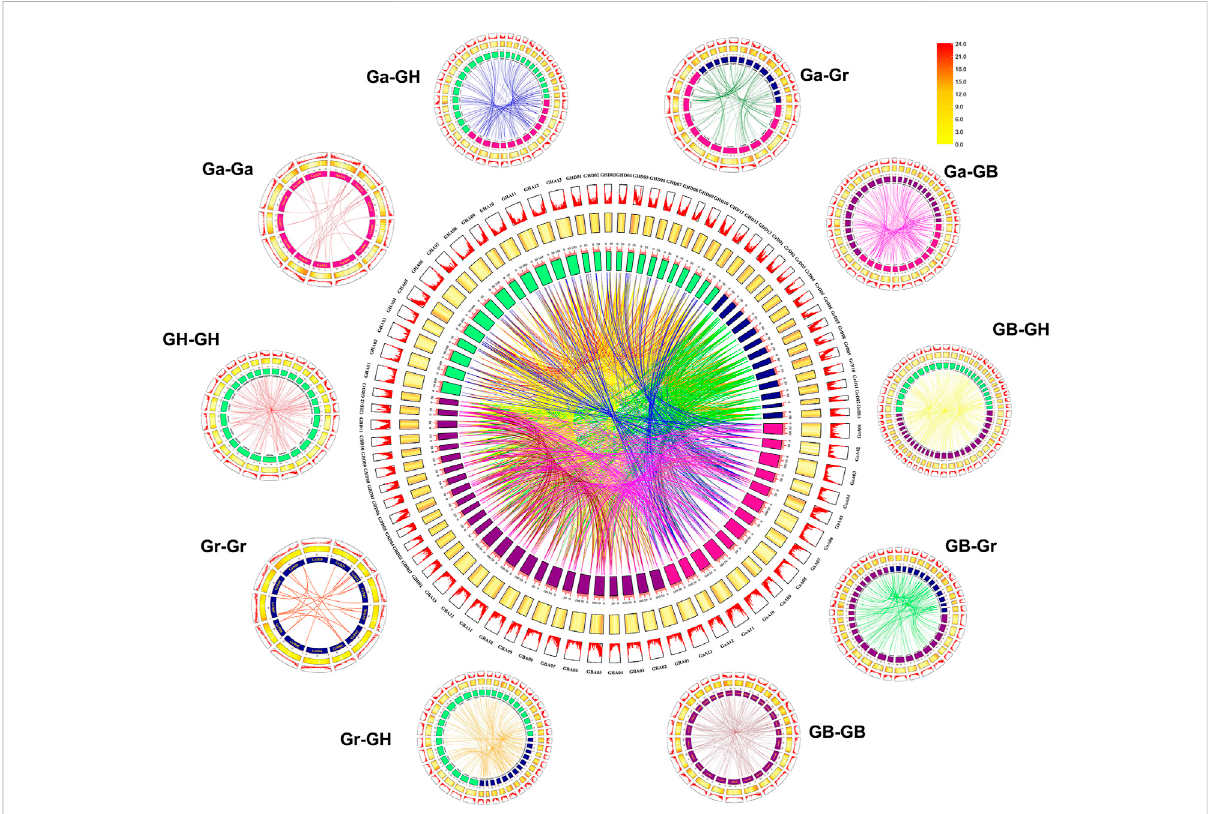
FIGURE 6 Syntenic relationship of UGT duplicated gene pairs in cotton. Chromosomal lines represented by different colours indicate various inter genome and intra genomic syntenic regions. The line map and heatmap of the outer rings represent the density of genes on chromosomes. G. hirsutum At subgenome “ GHA ” , G. hirsutum Dt subgenome “ GHD ” , G. barbadense At subgenome “ GBA ” , G. barbadense Dt subgenome “ GBD ” , G. arboreum A-genome “ GaA ” , and G. raimondii D-subgenome “ GrD ”